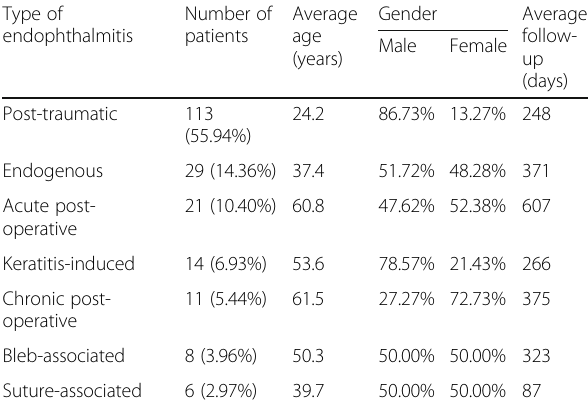
Table 1 Classification and demographic data of endophthalmitis cases ( n = 202). Post-traumatic cases made up more than half of the population, and were associated with younger age and a higher male to female